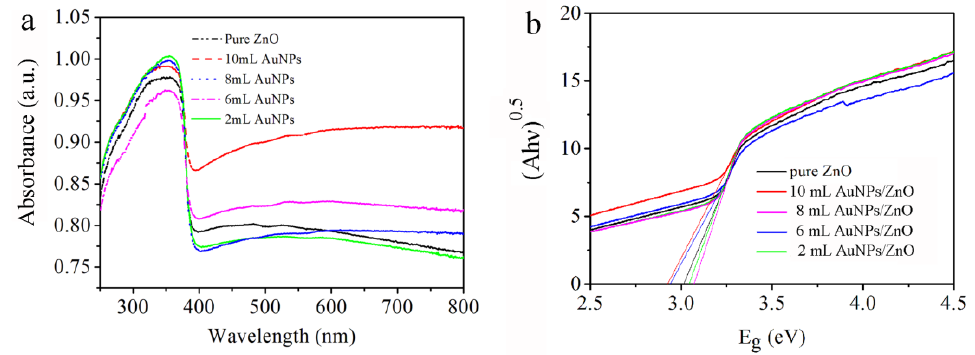
Figure 5. ( a ) Absorbance spectra and ( b ) Plot to determine the band gap energy of the AuNPs hybrid ZnO with different amount of